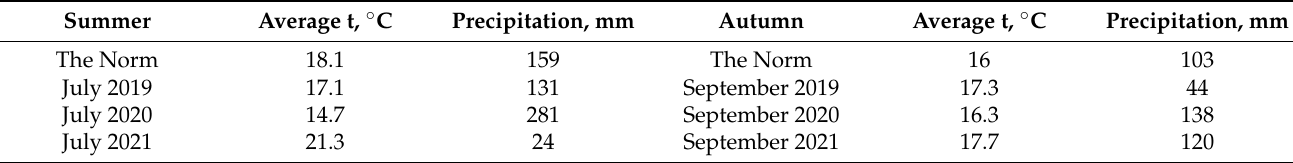
Table 1. The values of the average temperature and precipitation in 2019–2021 in Vladivostok, Primorsky Territory of Russia.